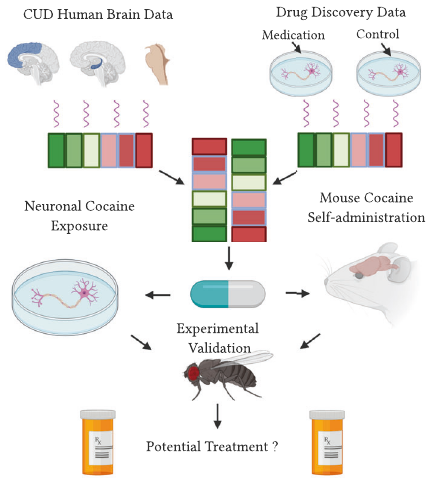
Fig. 1 Pictoral overview of the study. This schematic outlines the stages of the study from drug discovery (top), to computational follow-up (middle) and in-vivo validation